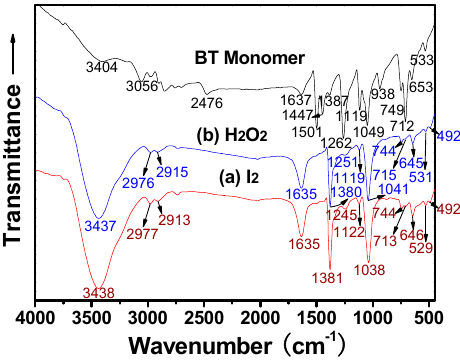
Figure 2. FT-IR spectra of BT monomer and PBT polymers prepared with (a) an I 2 /BT molar ratio of 1.5 and an initial BT concentration of 50 mmol L − 1 , and (b) an H 2 O 2 /BT molar ratio of 3.53 and an initial BT concentration of 58.25 mmol L − 1 in ethanol at 25 °C for 24 h.